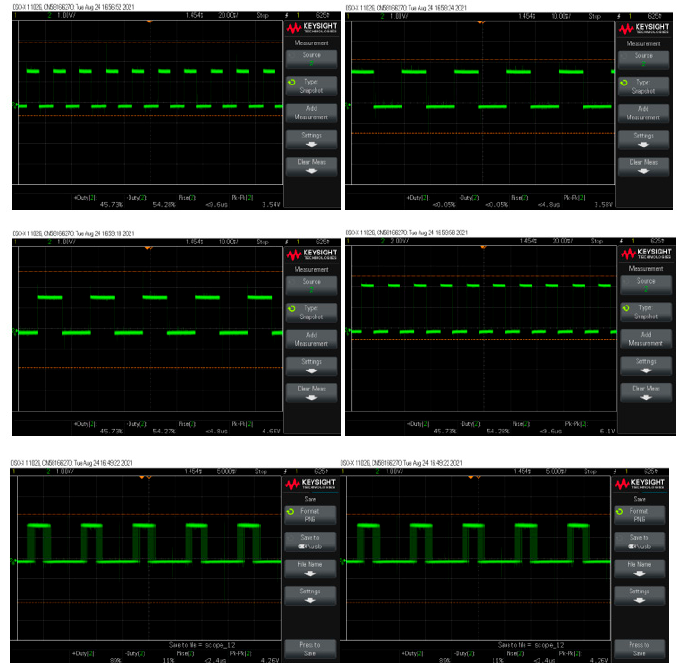
Figure 21. Gate pulses for switches S 1 –S 6 .